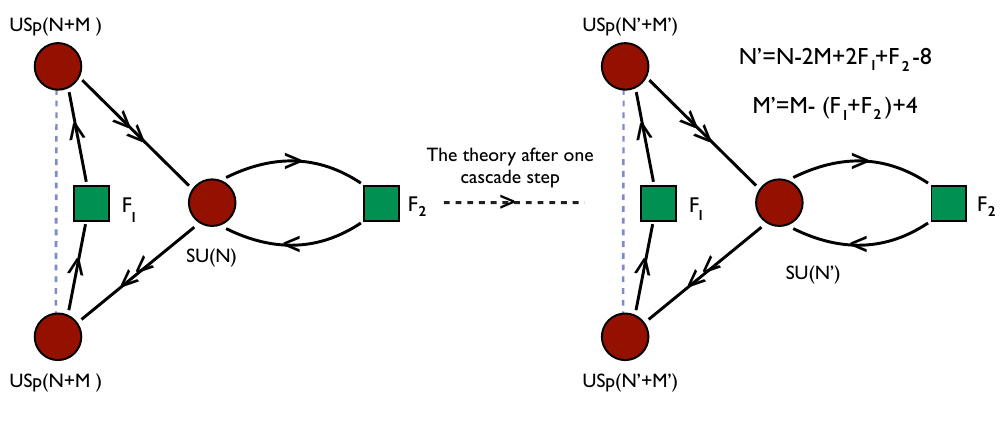
Figure 6 . The e(cid:11)ect of a cascade step on the F